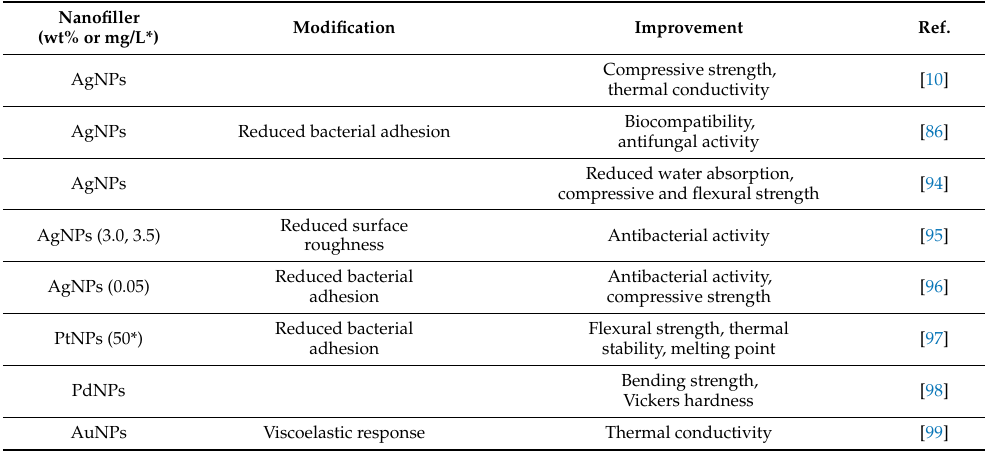
Table 1. Improvements in PMMA/nanofiller nanocomposites used for odontological